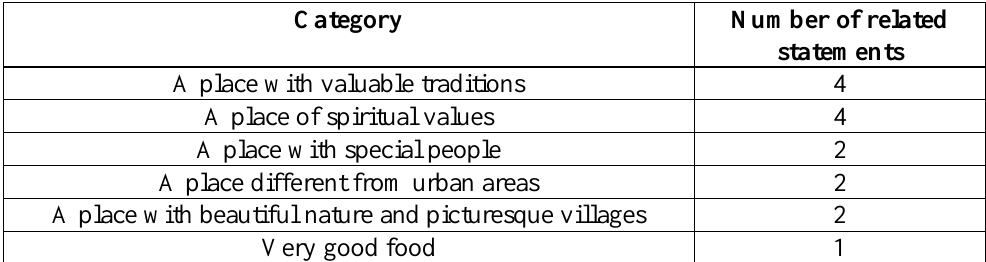
Table1: Key themes associated with Fagaras Land Category